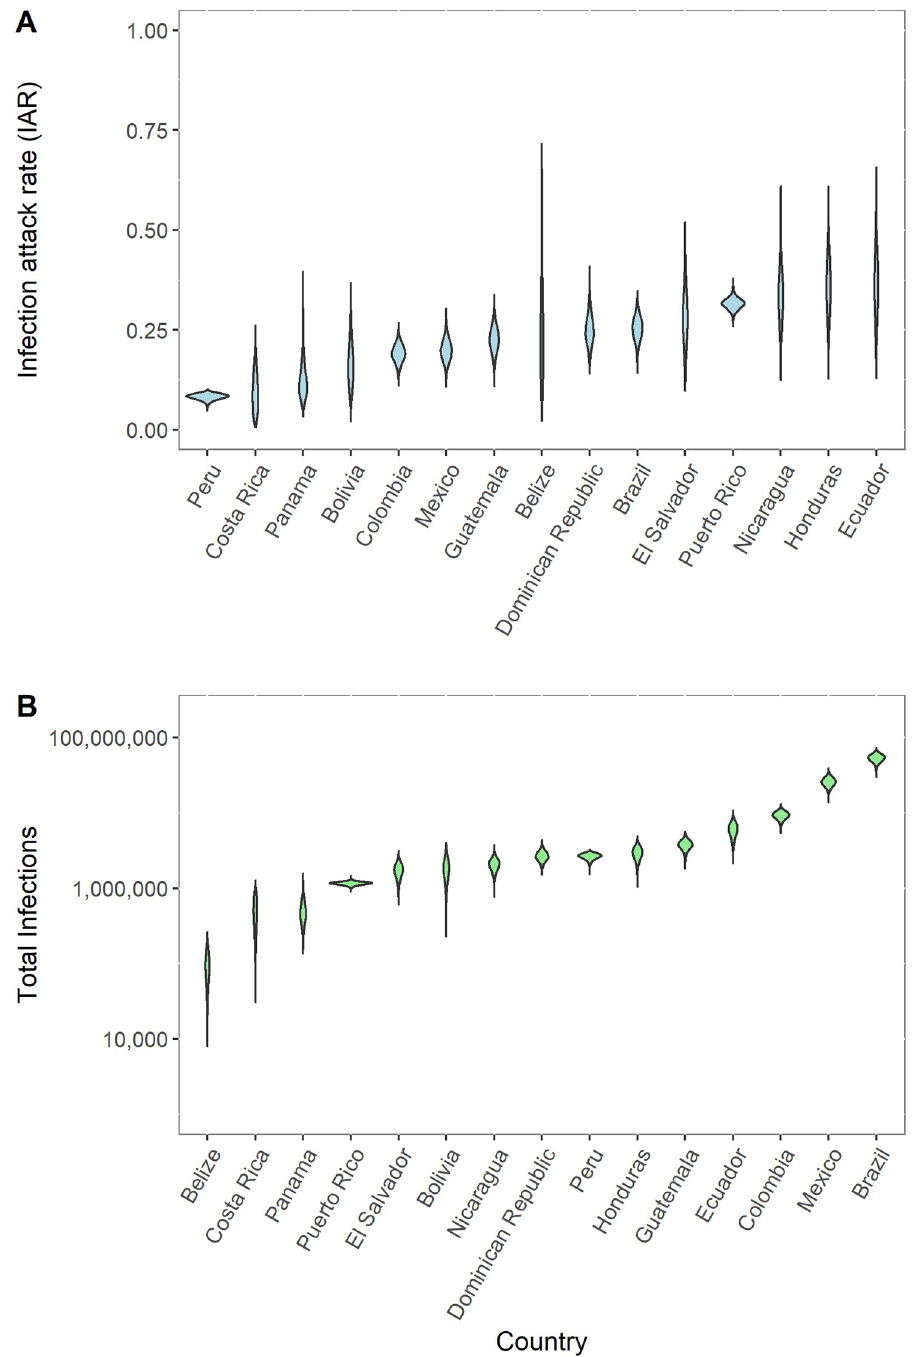
Fig 2. Posterior distributions of national ZIKV infection attack rate (IAR) and total ZIKV infections for 15 different countries and territories. (A) ZIKV IAR for each modeled country or territory ordered by median IAR. (B) Estimated number of ZIKV infections for each country or territory ordered by median number of infections.